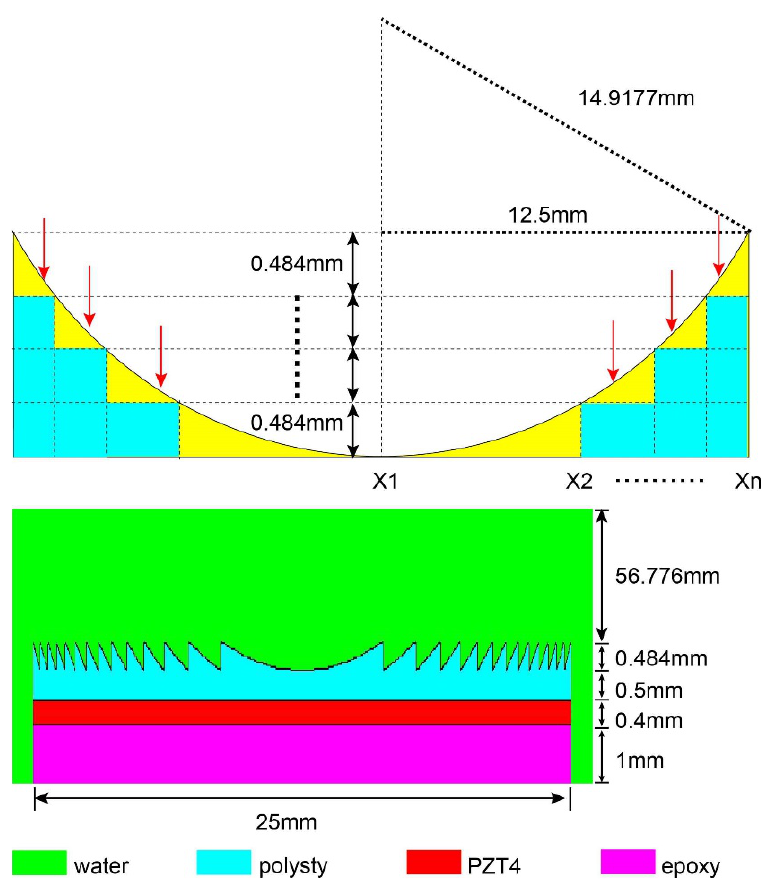
Figure 2. Designed specification of the Fresnel lens-focused ultrasonic transducer. At a design frequency of 5 MHz, the wavelength in the lens is 0.484 mm. We divided the region along the wave propagation direction by an integer multiple of the wavelength, and then subtract the maximum integer wavelength thickness in each region to form the novel lens.